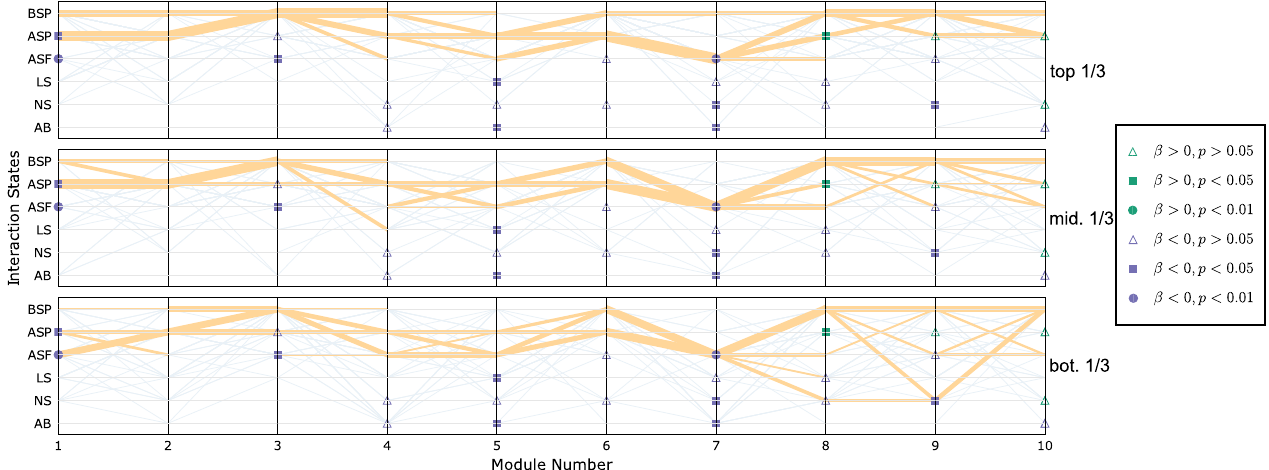
FIG. 4. Parallel coordinate graphs using level II (six)